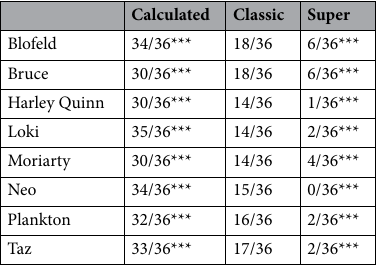
Table 4. Subjects’ performances in calculated, classic, and super contrafreeloading trials. *** p < 0.001.